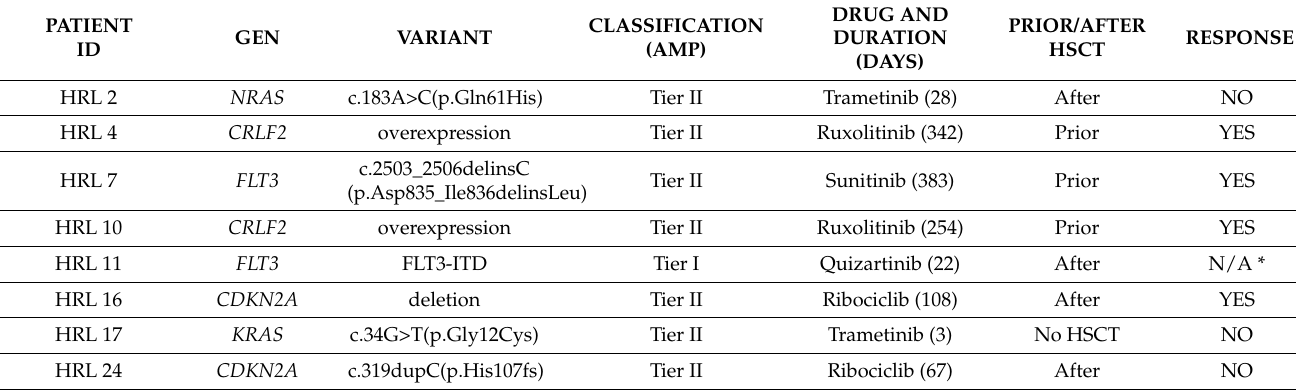
Table 2. Patients who received personalised